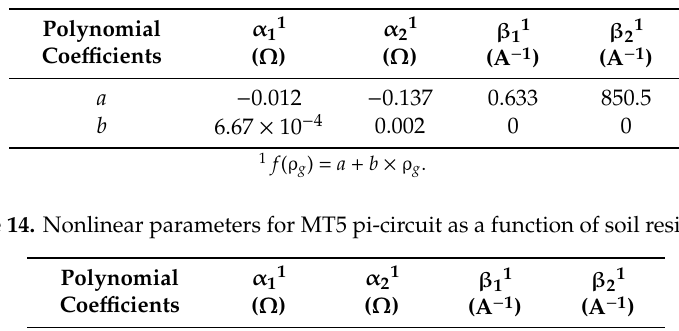
Table 13. Nonlinear parameters for MT4 pi-circuit as a function of soil resistivity.